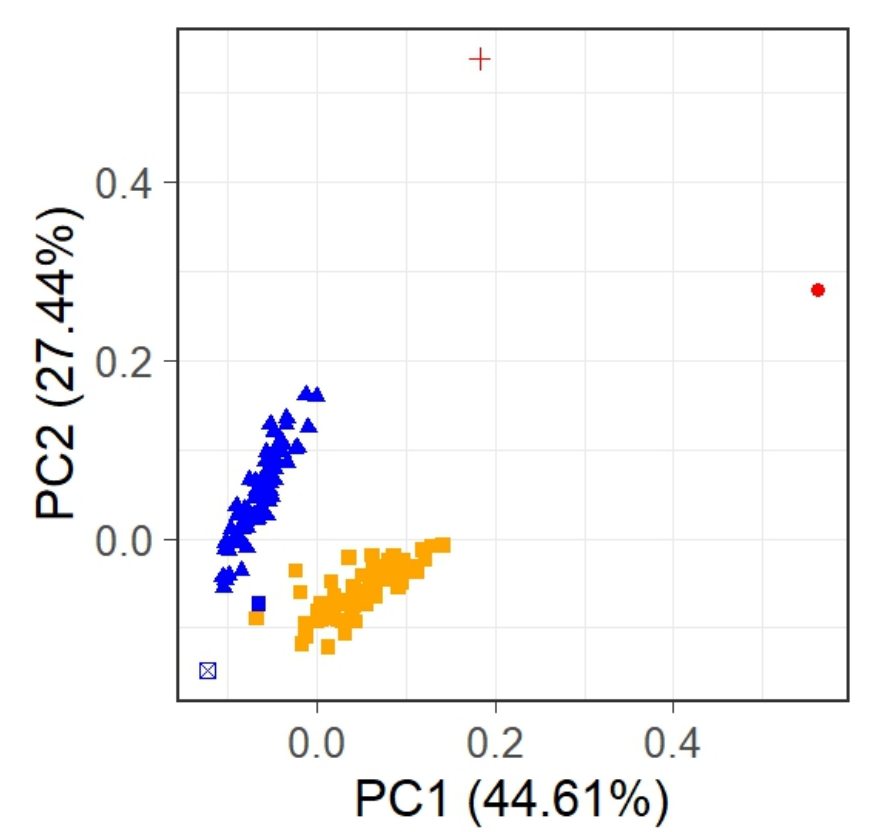
Figure 2. Principal coordinate analysis visualizing the relationship between the introgression populations and their respective parents. RTx436 is the recurrent parent for both populations, and PI152828 and GRIF809 are the introgression parents for GUESS 22 and GUESS 48, respectively.